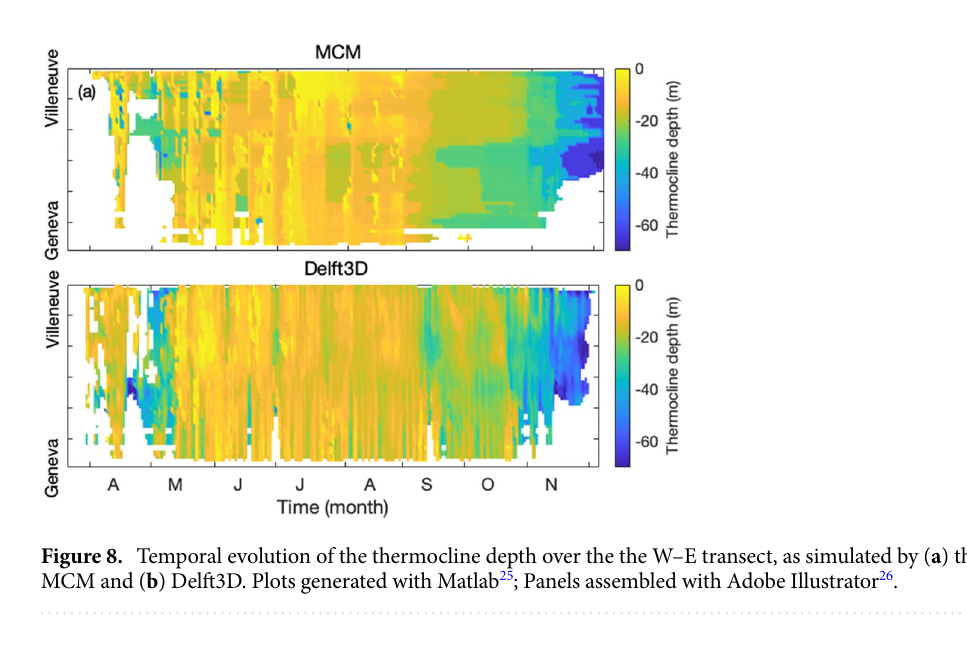
Figure 7. Season-averaged W–E transects (See Fig. 1) for the MCM (col 1), Delft3D (col 2), and the difference MCM–Delft3D (col 3). ( a – c ) Winter (DJF), ( d – f ) Spring (MAM), ( g – i ) Summer (JJA), ( j – l ) Autumn (SON). See Fig. S2 for monthly details. Plots generated with Matlab 25 ; Panels assembled with Adobe Illustrator 26 .